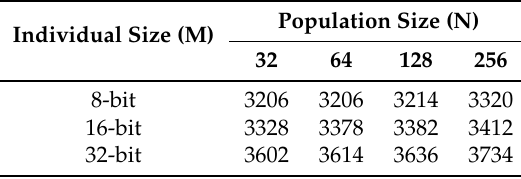
Table 2. Program memory consumption (in bytes) in the master node, of a total of 32 KB.